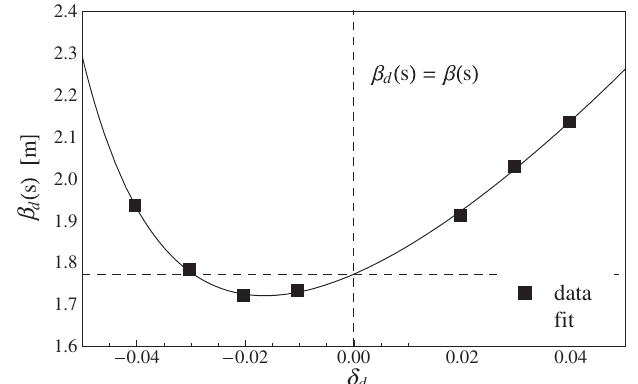
FIG. 6. (cid:1) d ð s Þ vs (cid:3) d at an interaction of the Tevatron (B0). Each data point is from the fit of Eq. (24) to an ellipse in Fig. 5. The curve is the fit of Eq. (6) to the data points. The true (cid:1) function of this location is the value of (cid:1) d ð s Þ when (cid:3) d ¼ 0 .